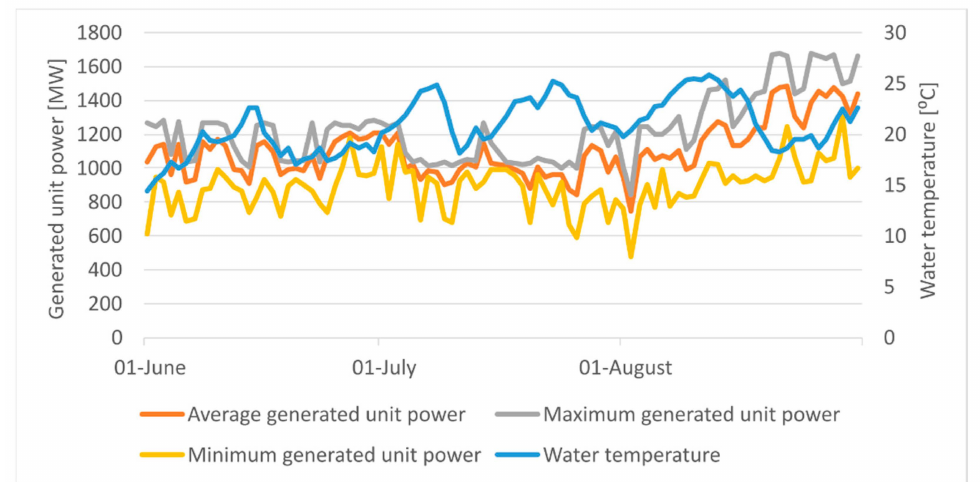
Figure 14. Water temperature diagram in the Wisła River (Szczucin) with the minimum, average, and maximum daily power generated in the Połaniec power plant.